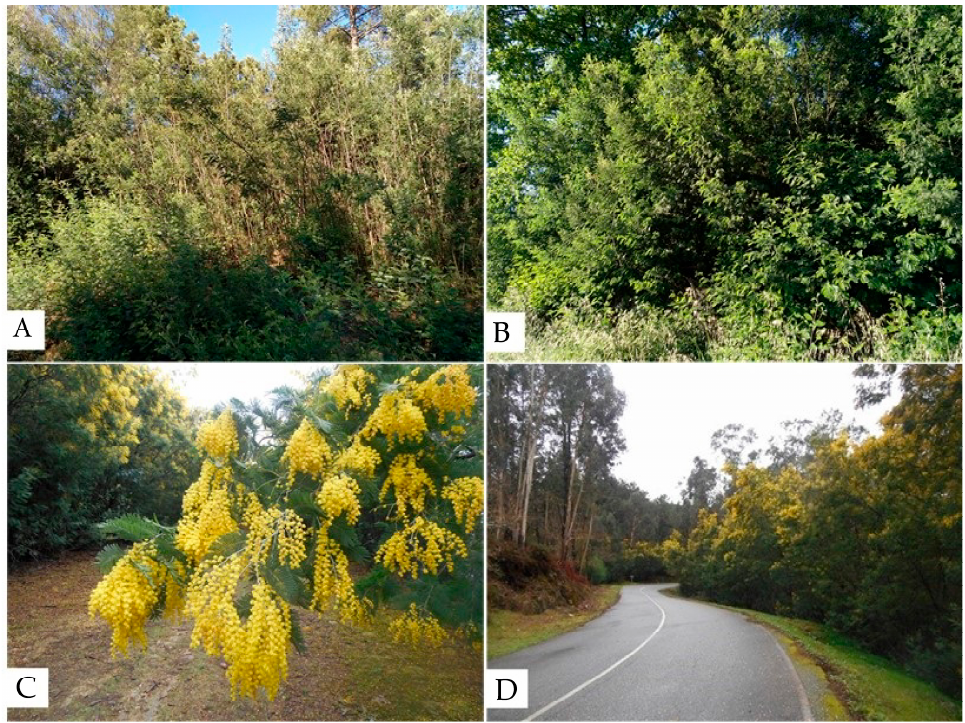
Figure 1. Pictures of A. dealbata in Galicia (NW Spain) at different phenological stages. Images (a-b) were taken after blooming period and (c-d) were taken when the species is in bloom.